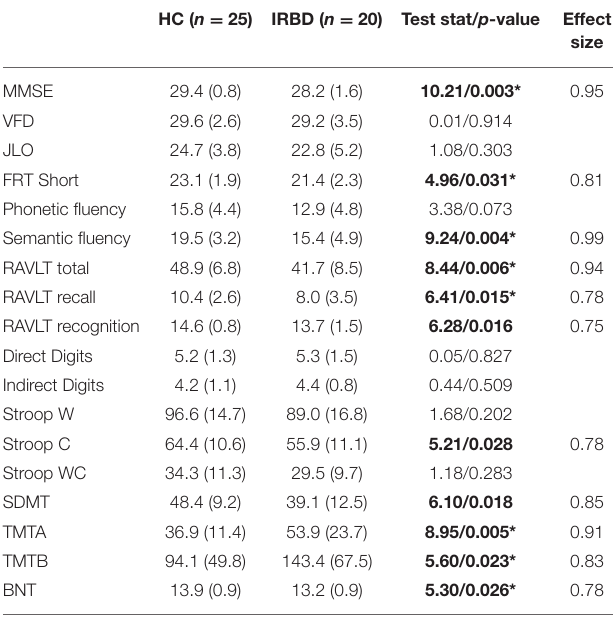
TABLE 2 | Group comparison of neuropsychological